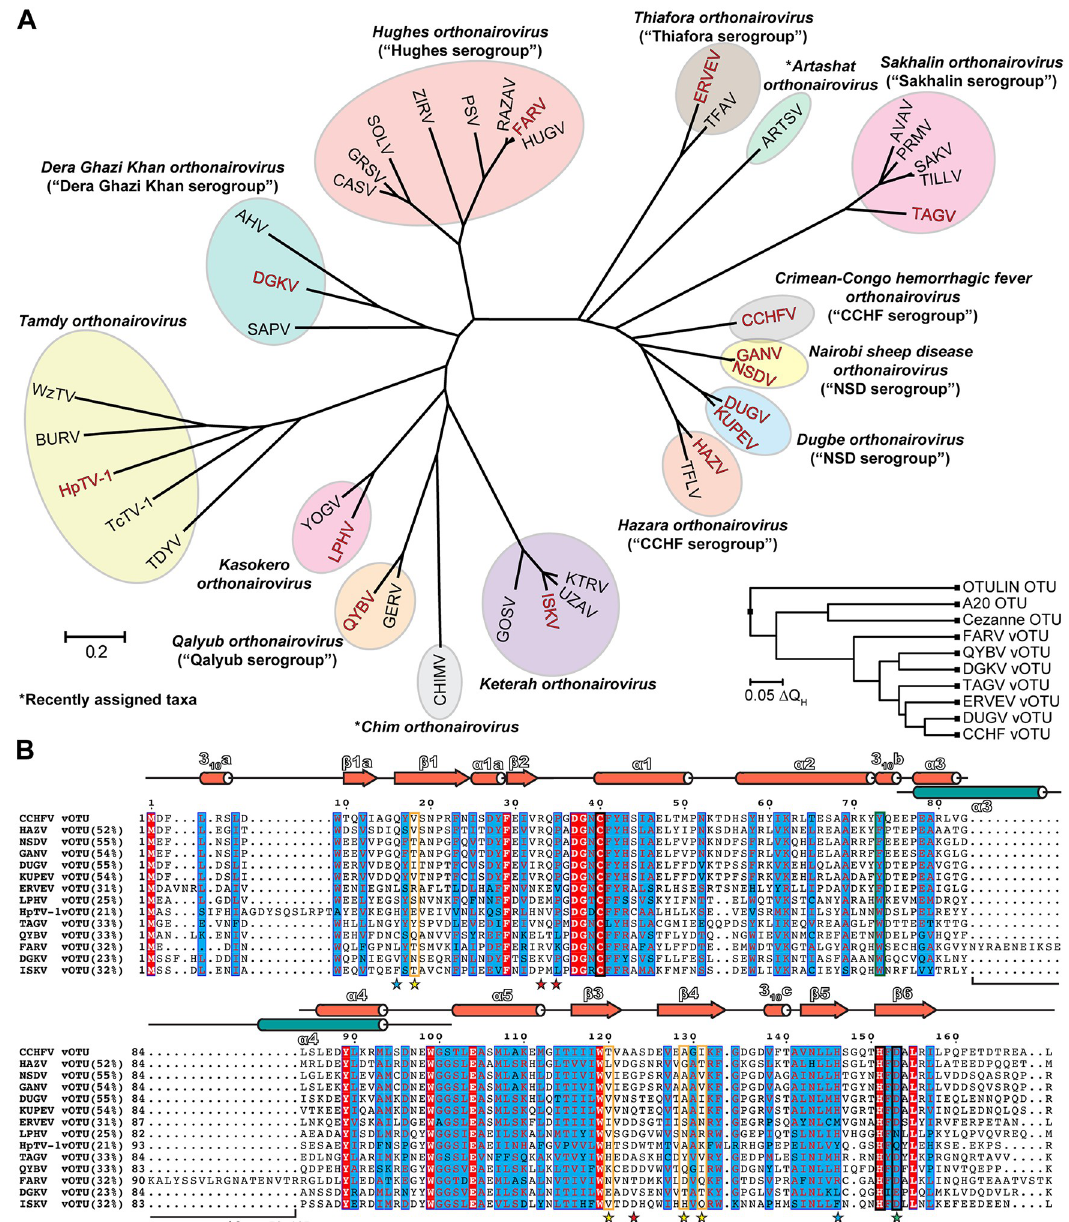
Fig 1. Sequence and structural diversity of nairovirus vOTUs. (A) Phylogenetic tree of CLUSTALW aligned nairovirus vOTUs. The tree was constructed utilizing the Jones-Thornton-Taylor model in the MEGA7 program [70]. Current species groupings are indicated by colored ovals, and the assigned species denoted. Previous serogroup classification, if applicable, is shown in parentheses. Virus vOTUs included in this study are denoted by red lettering. Inset is a structure-based phylogenetic tree of vOTUs, with the mammalian Cezanne, A20, and OTULIN OTUs included for comparison. The tree was constructed using PDB IDs 3PRP, 4HXD, 5JZE, 6DX1, 6DX2, 6DX3, 6DX5, 5LRV, 5LRX, and 3ZNZ in the MultiSeq module of VMD [71]. Sequence accession numbers are included in S1 Table. CCHFV, Crimean-Congo hemorrhagic fever virus; GANV, Ganjam virus; NSDV, Nairobi sheep disease virus; DUGV, Dugbe virus; KUPEV, Kupe virus; HAZV, Hazara virus; TFLV, Tofla virus; TAGV, Taggert virus; TILLV, Tillamook virus; SAKV, Sakhalin virus; PRMV, Paramushir virus; AVAV, Avalon virus; ARTSV, Artashat virus; TFAV, Thiafora virus; ERVEV, Erve virus; HUGV, Hughes virus; FARV, Farallon virus; RAZAV, Raza virus; PSV, Punta Salinas virus; ZIRV, Zirqa virus; SOLV, Soldado virus; GRSV, Great Saltee virus; CASV, Caspiy virus; AHV, Abu Hammad virus; DGKV, Dera Ghazi Khan virus; SAPV, Sapphire II virus; WzTV, We¯nzh ō u tick virus; BURV, Burana virus; HpTV-1, Hua´ngpı´tick virus 1; TcTV-1, Taˇche´ng tick virus 1; TDYV, Tamdy virus; YOGV, Yogue virus; LPHV, Leopards Hill virus; QYBV, Qalyub virus; GERV, Geran virus; CHIMV, Chim virus; GOSV, Gossas virus; ISKV, Issyk-kul virus; UZAV, Uzun-Agach virus; KTRV, Keterah virus. (B) Nairovirus vOTUs tested in this